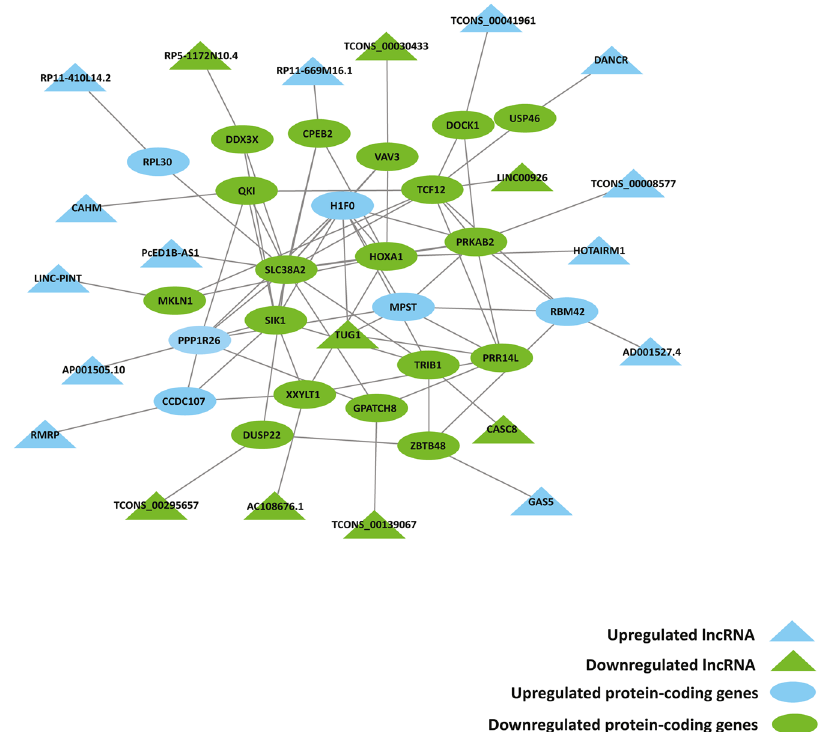
Figure 5. The interaction network of DE lncRNAs with their co-located DE protein-coding genes in primary monocytes of XLA patients compared to healthy subjects. The DE protein-coding genes were connected in a network based on the protein-protein interactions. The edges for lncRNAs that were close in genomic space to the DE protein-coding genes were automatically added into the network.